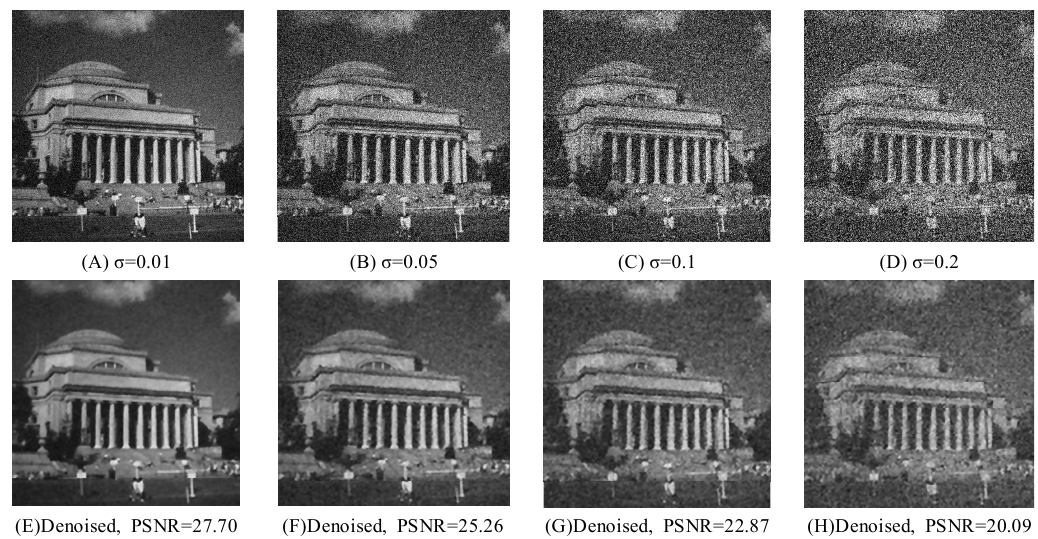
Figure 15. Denosing results of Columbia with Gaussian noise using IFOA-DTCWT-BF. ( A ) Columbia of noise σ = 0.01; ( B ) Columbia of noise σ = 0.05; ( C ) Columbia of noise σ = 0.1; ( D ) Columbia of noise σ = 0.2; ( E ) Denoised image of σ = 0.01; ( F ) Denoised image of σ = 0.05; ( G ) Denoised image of σ = 0.1; ( H ) Denoised image of σ = 0.2.